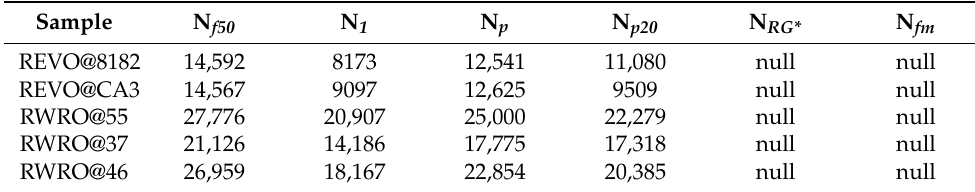
Table 7. Fatigue life of rejuvenated asphalt (4.5% strain-control).